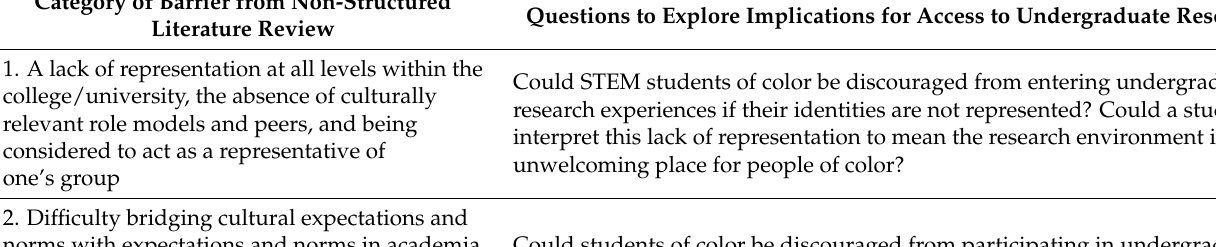
Table 2. Ten categories of barriers to success for STEM undergraduate students of color resulting from the preliminary non-structured literature review and questions we pose to encourage researchers to explore whether these barriers manifest as challenges in access to undergraduate research opportunities for STEM students of